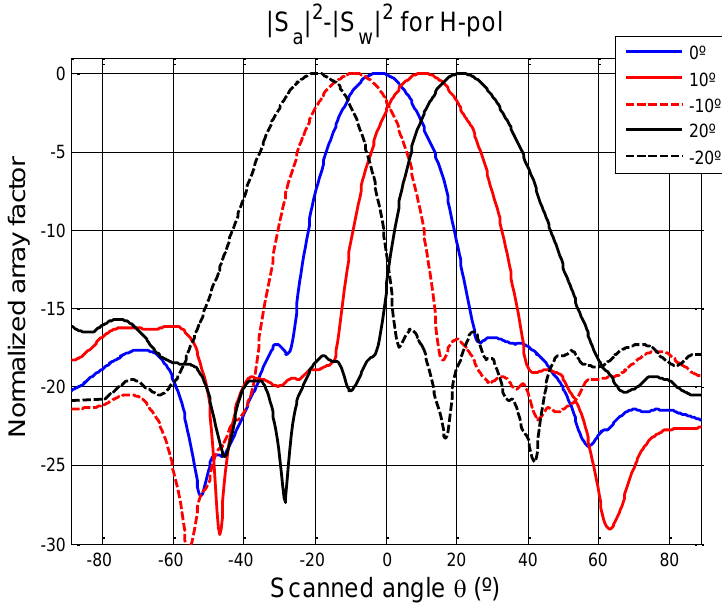
Figure 16. PAU-RAD DBF results. Measured normalized array factors in dB for multiple beams (H-pol and scanning the θ domain